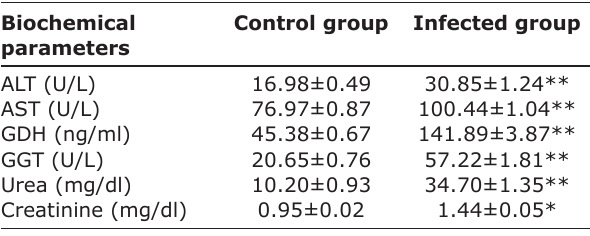
Table-1: Some serum biochemical profiles (Mean±S.E), for normal (Control group) and Fasciola hepatica infected cattle (Infected group).